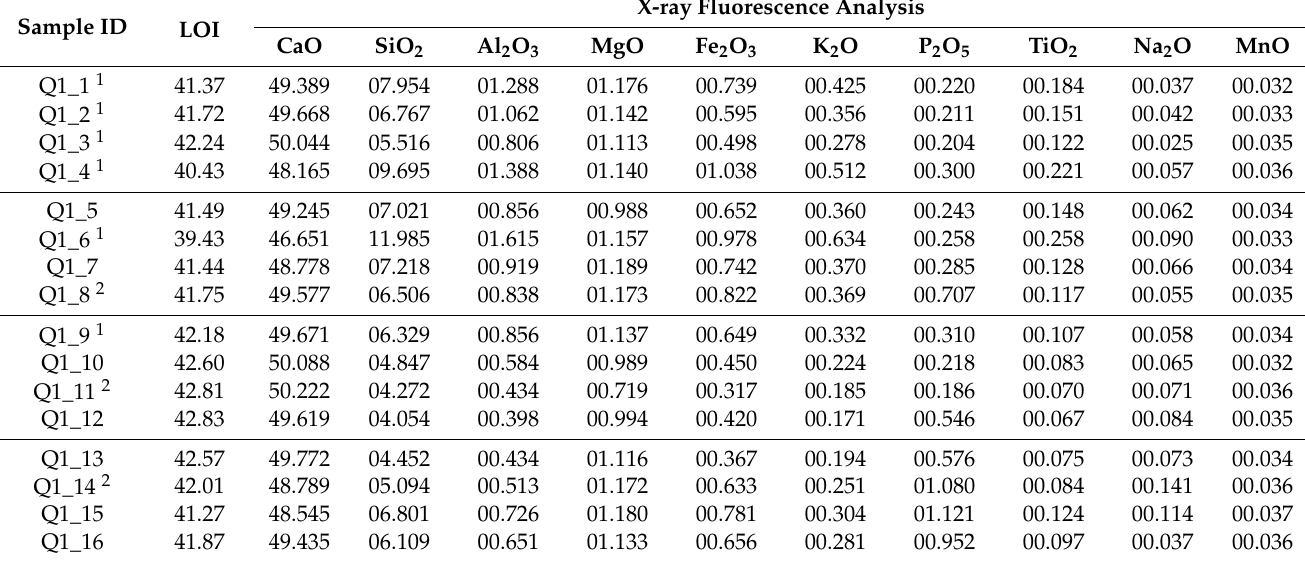
Table 3. LOI and chemical composition